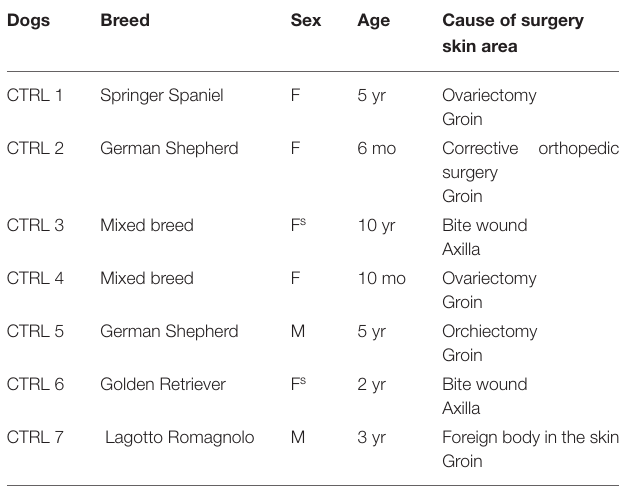
TABLE 2 | Clinical data of the control dogs (CTRL) enrolled in the present